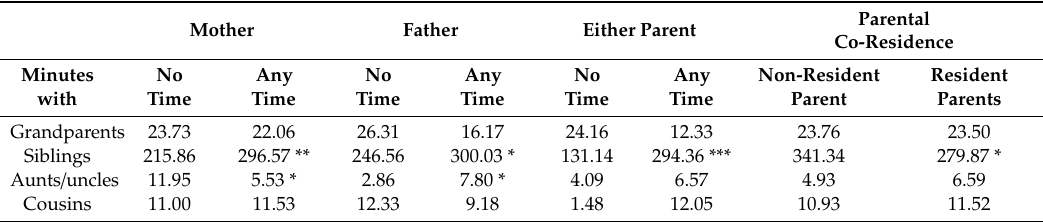
Table 2. Minutes Spent with Family Members across Di ff erent Parental Availability Measures ( n = 1568 Adolescents). Mother Father Either Parent